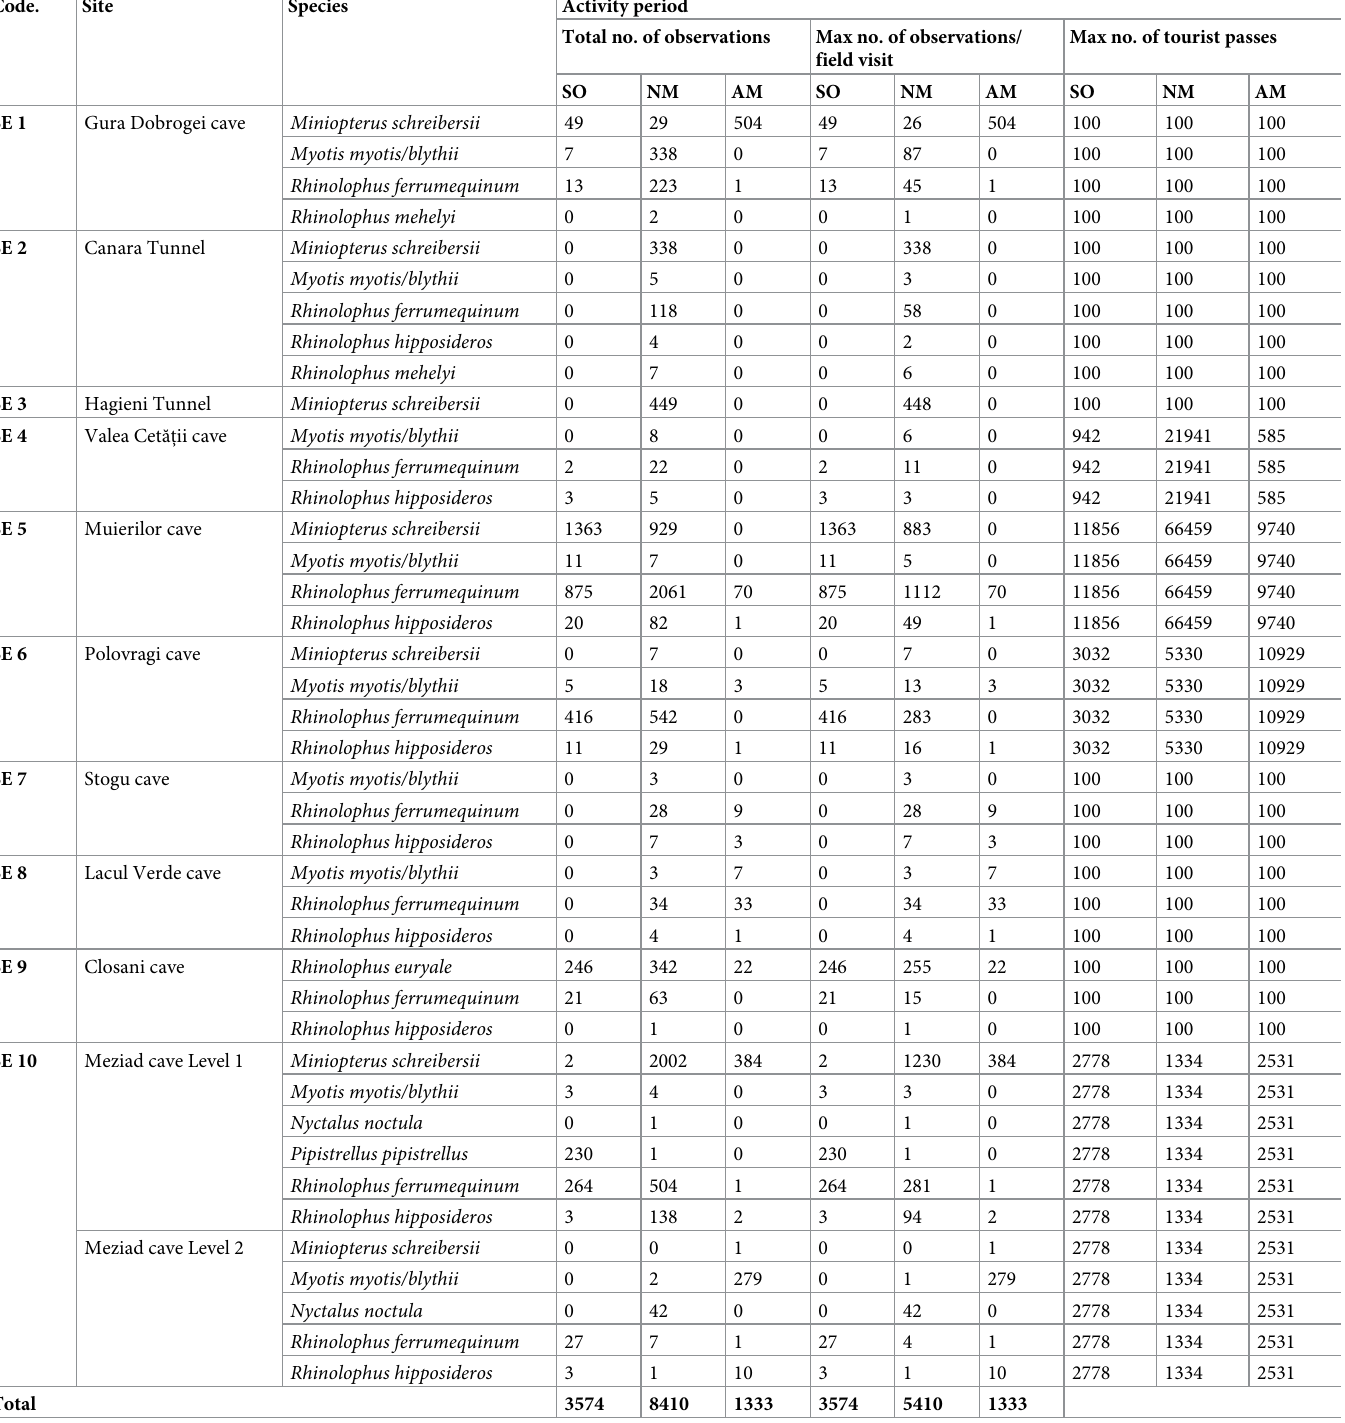
Table 2. Occurrences per species detailed by SE, activity period, and a maximum number of tourists’ passes per bat activity period for the 2014–2016 observation interval.